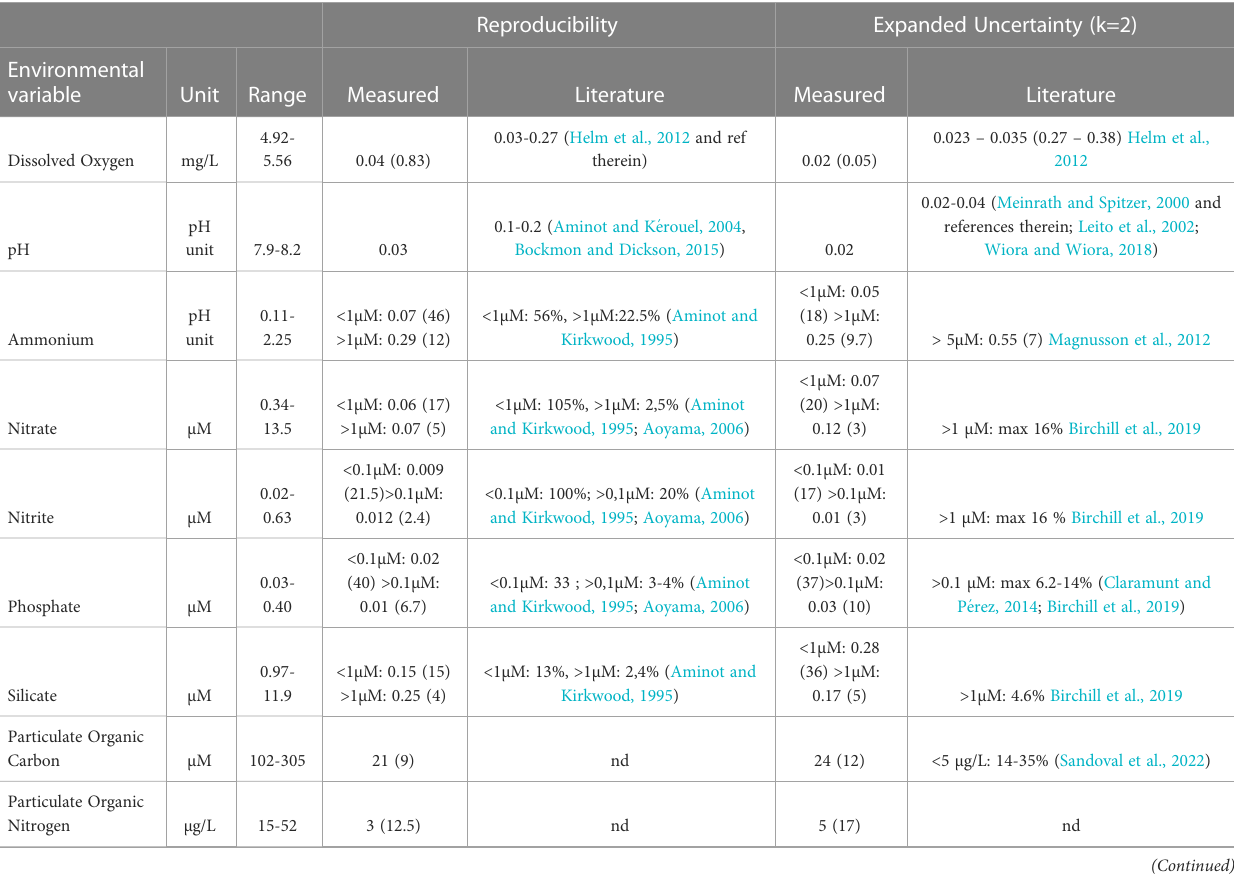
TABLE 1 Range, reproducibility, and expanded uncertainty of the environmental variables measured during inter-laboratory comparison exercises of the SOMLIT network over the last 6